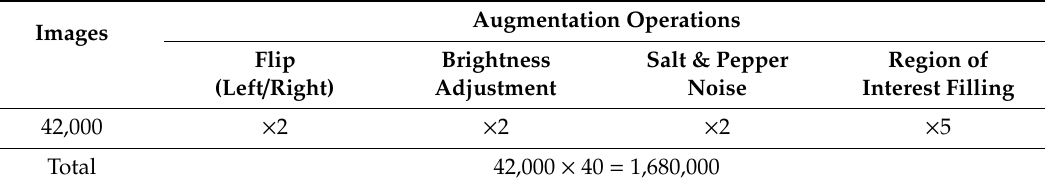
Table 2. Image dataset